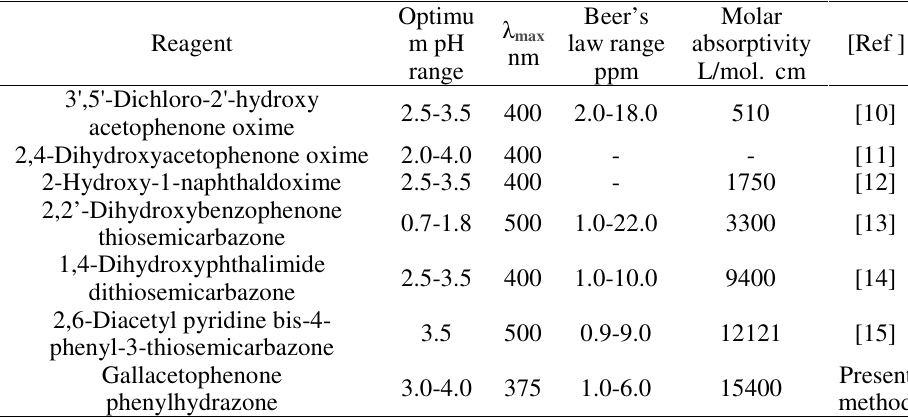
Table 6. Comparison of the present method with other reported spectrophotometric methods for determination for